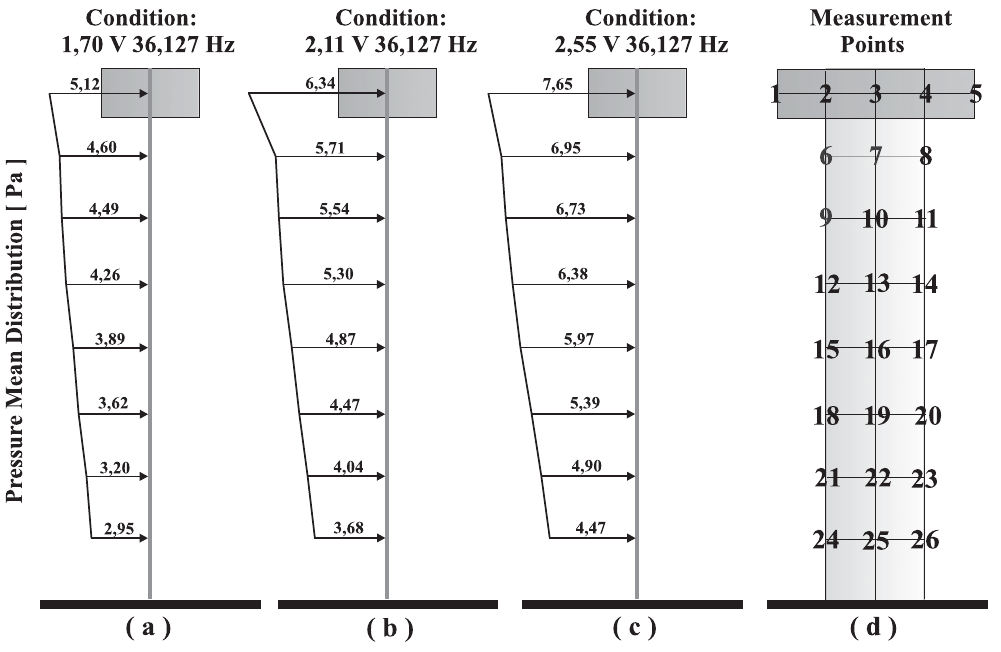
Fig. 11. Experimental pressure distribution over the structure for acoustic source’s input at 36.127 Hz and three different amplitudes: (a) 1.70 V; (b) 2.11 V; (c) 2.11 V and (d) measured